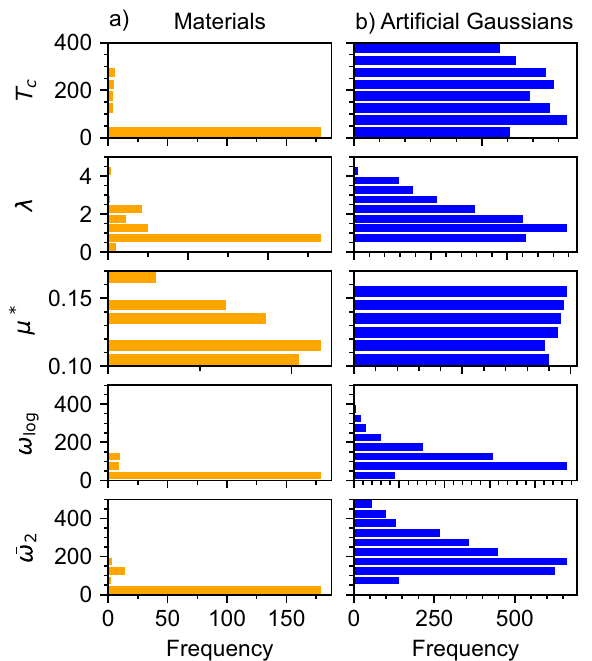
Fig. 3 Histograms of input spaces of materials data and arti fi cial Gaussian models. Compared to a the materials data, b the arti fi cial Gaussian models exhibit superior coverage of the input spaces. We generated arti fi cial Gaussian models by sampling inputs uniformly with Sobol sequences and retaining entries with T c ≤ 400.